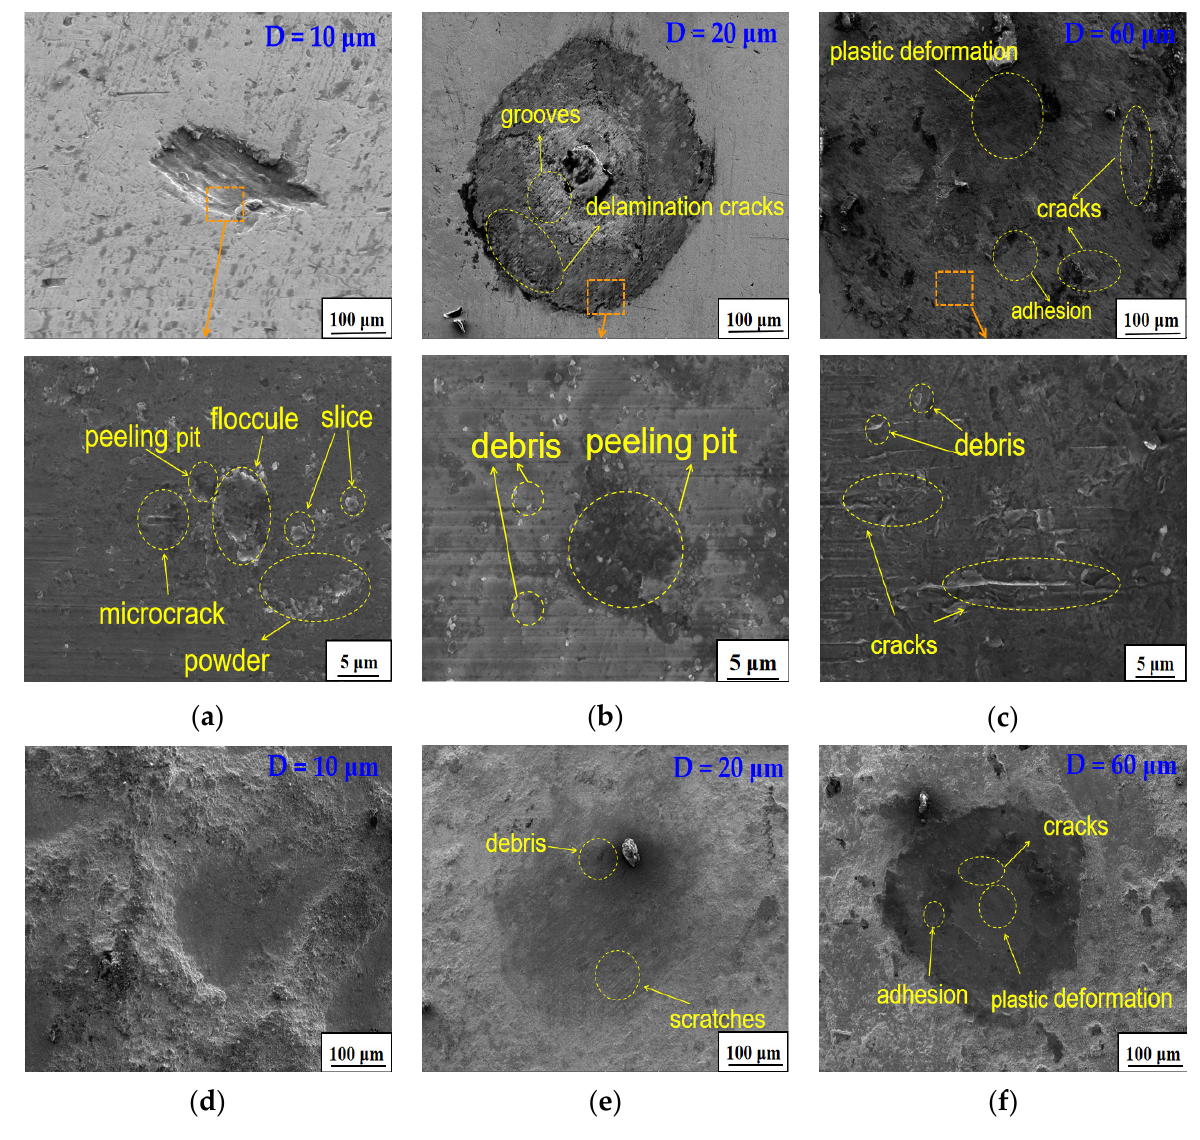
Figure 12. Representative SEM results of wear surfaces on GCr15 steel balls at different displacement amplitudes. ( a ) Untreated, D = 10 μ m; ( b ) untreated, D = 20 μ m; ( c ) untreated, D = 60 μ m; ( d ) pro. in 18 h, D = 10 μ m; ( e ) pro. in 18 h, D = 20 μ m; ( f ) pro. in 18 h, D = 60 μ m.